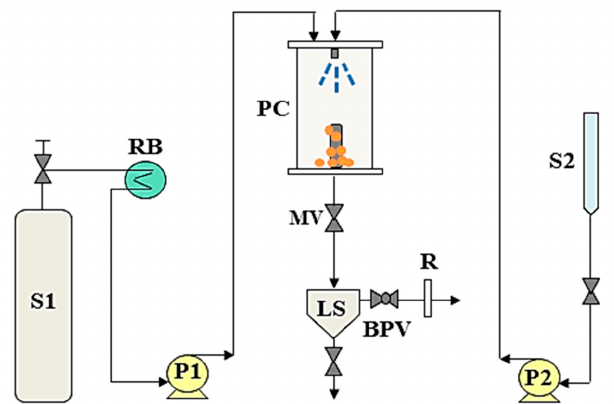
Figure 2. A scheme of the supercritical antisolvent (SAS) apparatus. P1, P2: Pumps; S1: CO 2 supply;